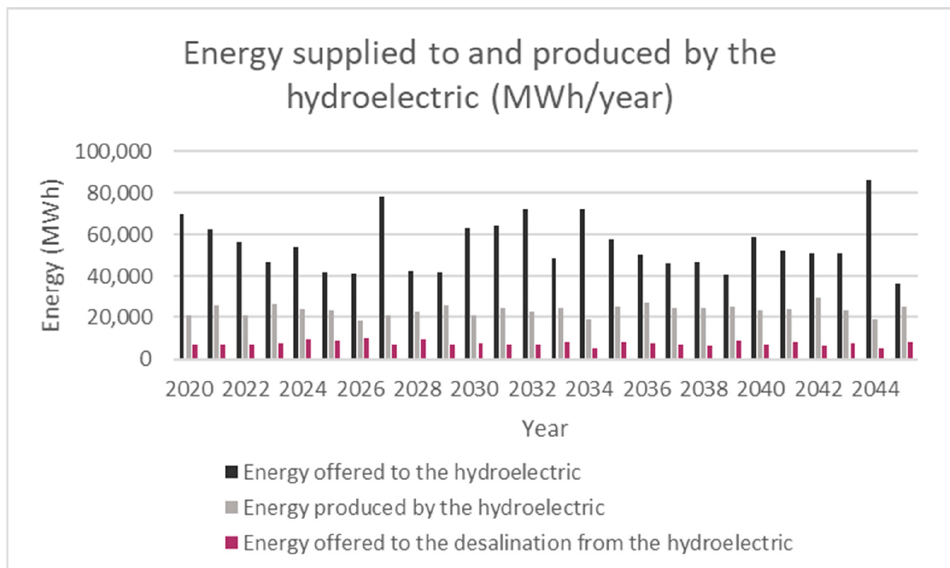
Figure 10. Energy supplied to and produced by the hydroelectric plant.